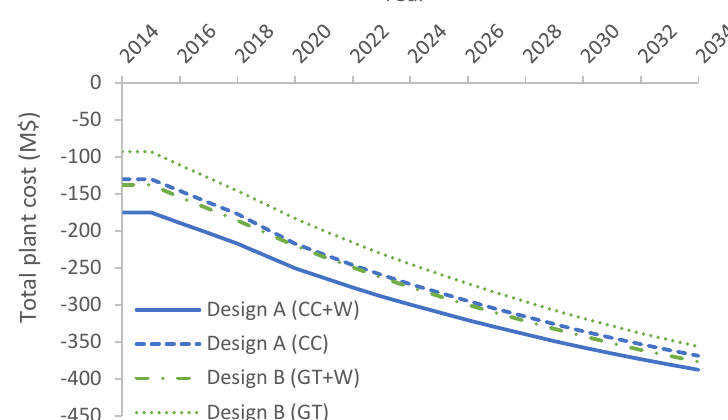
Figure 11. Evolution of the total plant cost throughout plant’s lifetime for the concepts analysed: Design A (CC+W), Design A (CC), Design B (GT+W) and Design B (GT).